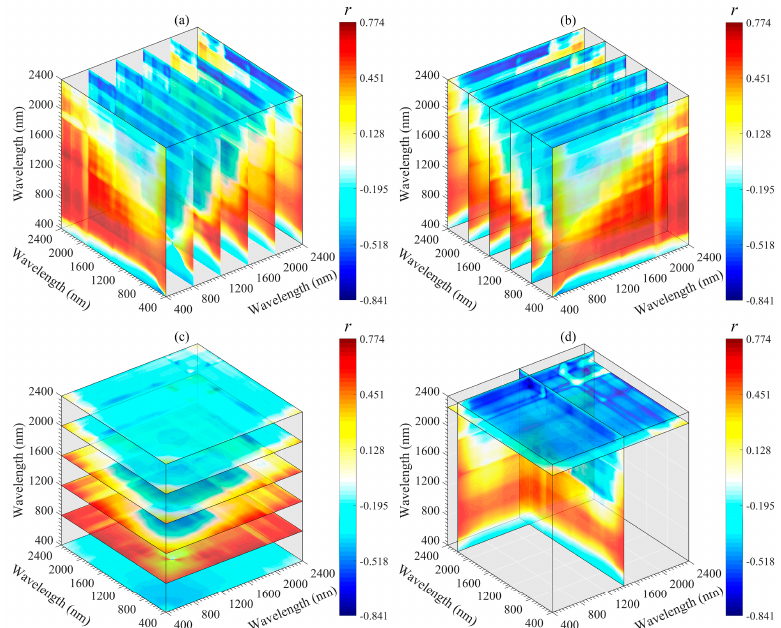
Figure 7. Three-dimensional slice maps of correlations between SOM content and TBI2 based on the calibration set ( n = 112). ( a – c ) represent slice maps based on the x -axis, y -axis, and z -axis, respectively, and ( d ) represents the optimal slice map.